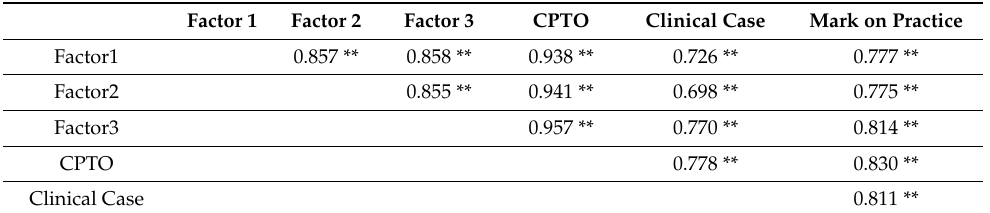
Table 2. Relations between CPTO and clinical case and final mark on practice.